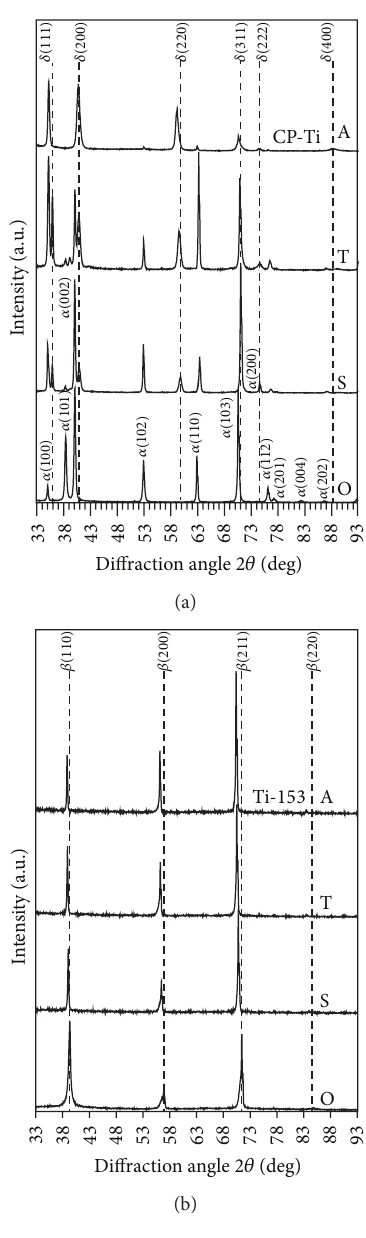
Figure 3: XRD patterns for as-received specimens and those after cathodic charged in various electrolytes: (a) CP-Ti and (b) Ti-153.